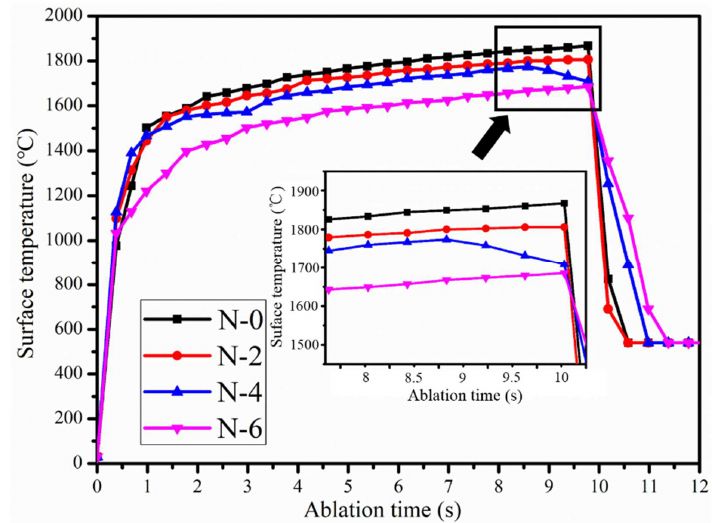
Figure 9. Ablation surface temperature curves of NiCoCrAlY/MSZ composite coatings before and after NSS test.